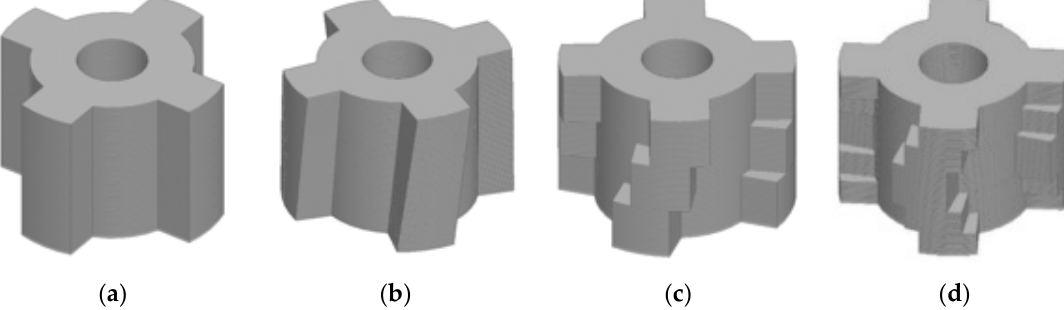
Figure 1. Different types of 4-pole SRM rotors: ( a ) non-skewed rotor, ( b ) continuously skewed rotor, ( c ) symmetrical step-skewed rotor, and ( d ) V-shaped step-skewed rotor.